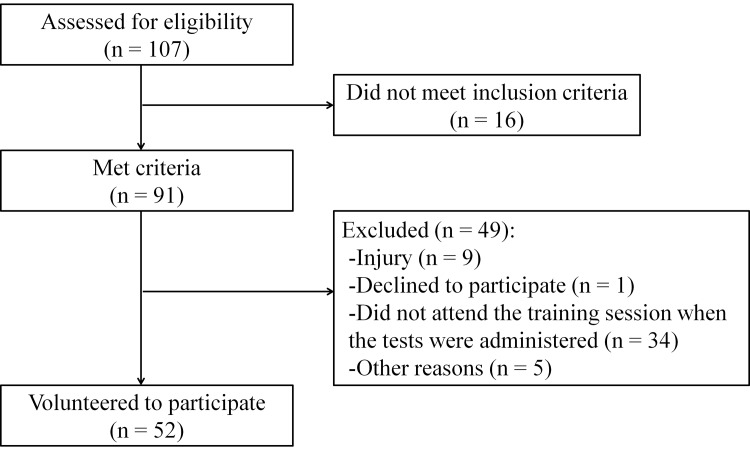
Recruitment flowchart.